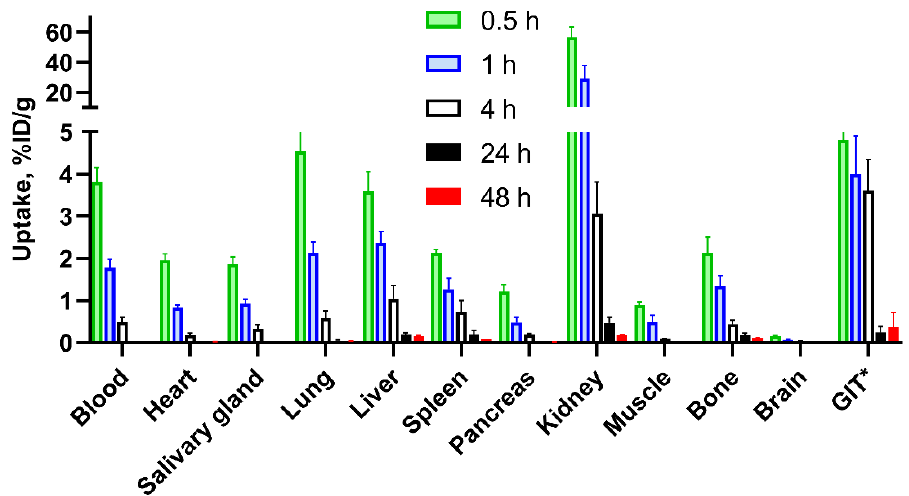
Figure 5. Biodistribution of 188 Re-ZHER2:41071 in NMRI mice at 0.5, 1, 4, 24, and 48 h after injection. *GIT = gastrointestinal tract. Data are presented as %ID per whole sample. Data are presented as an average ( n = 4) value ± SD.